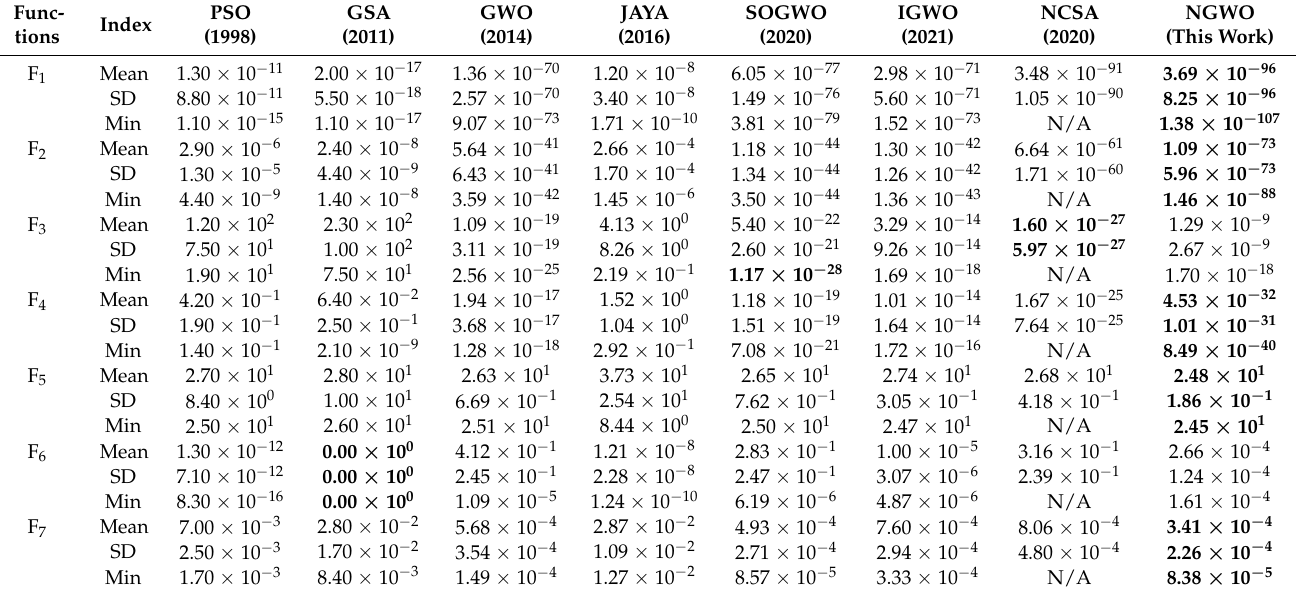
Table 3. Results of unimodal benchmarks (F 1 –F 7 ).